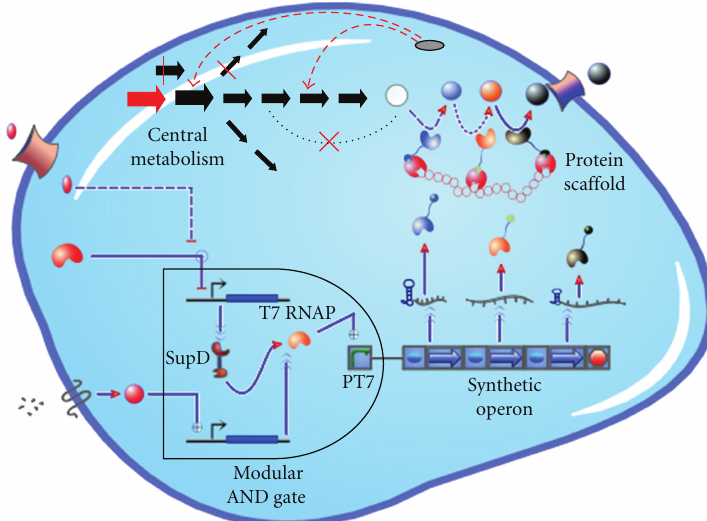
Figure 2: Cartoon of an engineered cell . Four distinct strategies have been combined to illustrate a synthetic biology approach to metabolic engineering. The engineered pathway is encoded by a synthetic operon designed from standard parts/components including tunable intergenic regions (TIGRs) that provide di ff erential control over mRNA stability [41]. An upstream device/module, a transcriptional modular AND gate acts as a master regulator by requiring two separate inputs to turn on expression of the pathway [15]. The enzymes have been tagged with a peptide ligand that binds them to a synthetic protein sca ff old , forming a complex of colocalized pathway enzymes [27]. The central metabolism of the host/chassis has been modified to interface with the engineered system/network, providing a su ffi cient flux of necessary precursors and cofactors as well as increased transporters to facilitate product secretion [7]. This image was generated in